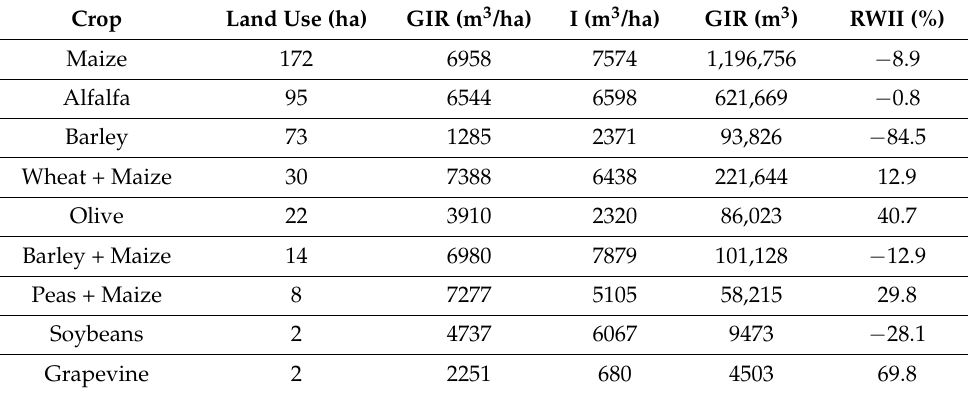
Table 7. Land use, gross irrigation requirements per hectare, average irrigation, total gross irrigation requirements and relative water irrigation index (RWII) for the crops in the AB5 basin during the study period.